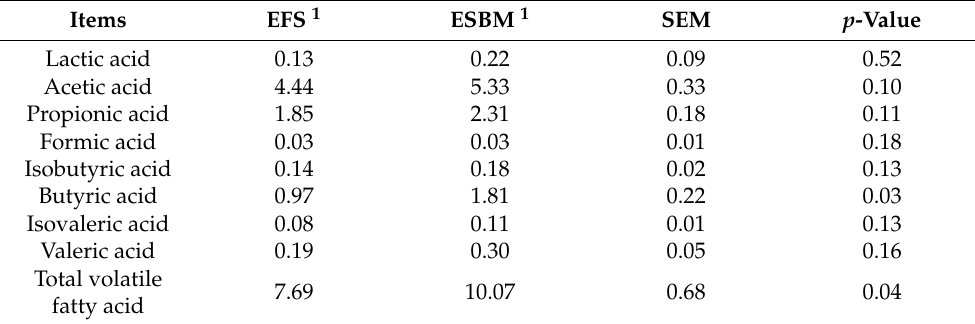
Table 8. Effects of enzyme-treated soybean meal replacing extruded full-fat soybean on the volatile fatty acids composition in feces